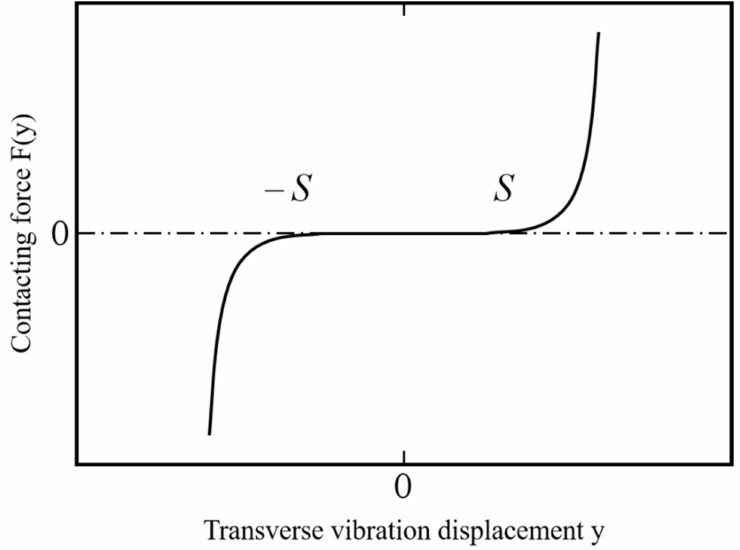
Figure 4. The relationship between collision force and distance between drillpipe and